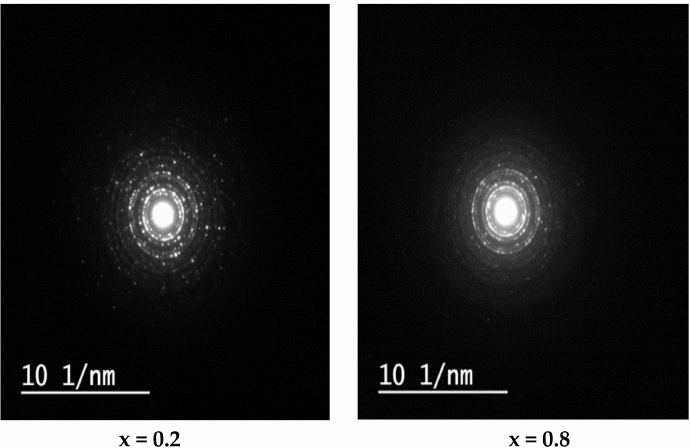
Figure 4. SAED patterns of Ni + 2